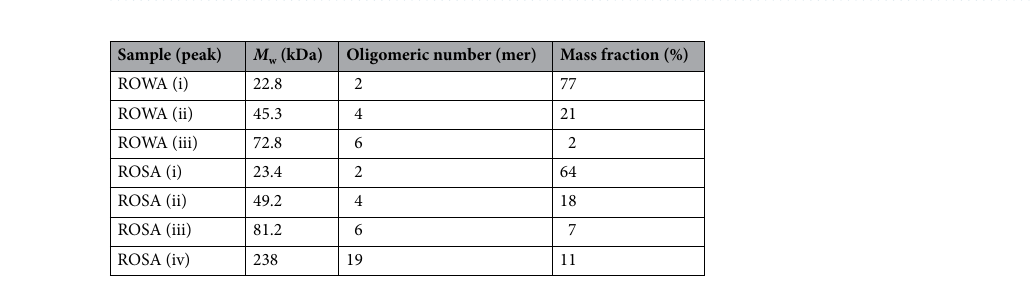
Table 3. Summary of the SEC–MALS results of ROWA and ROSA.